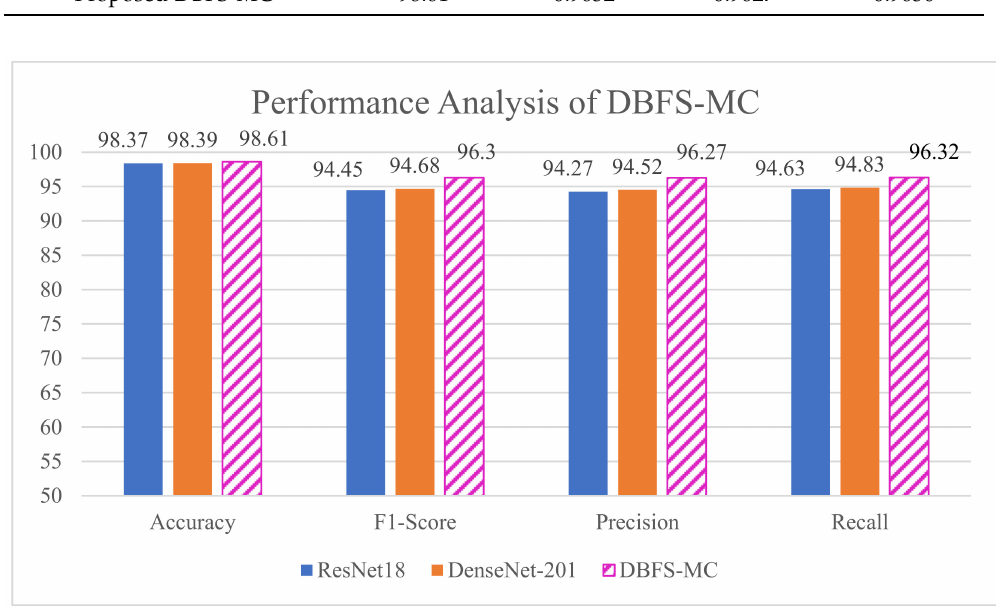
Figure 11. Performance improvement of the proposed DBFS-MC.